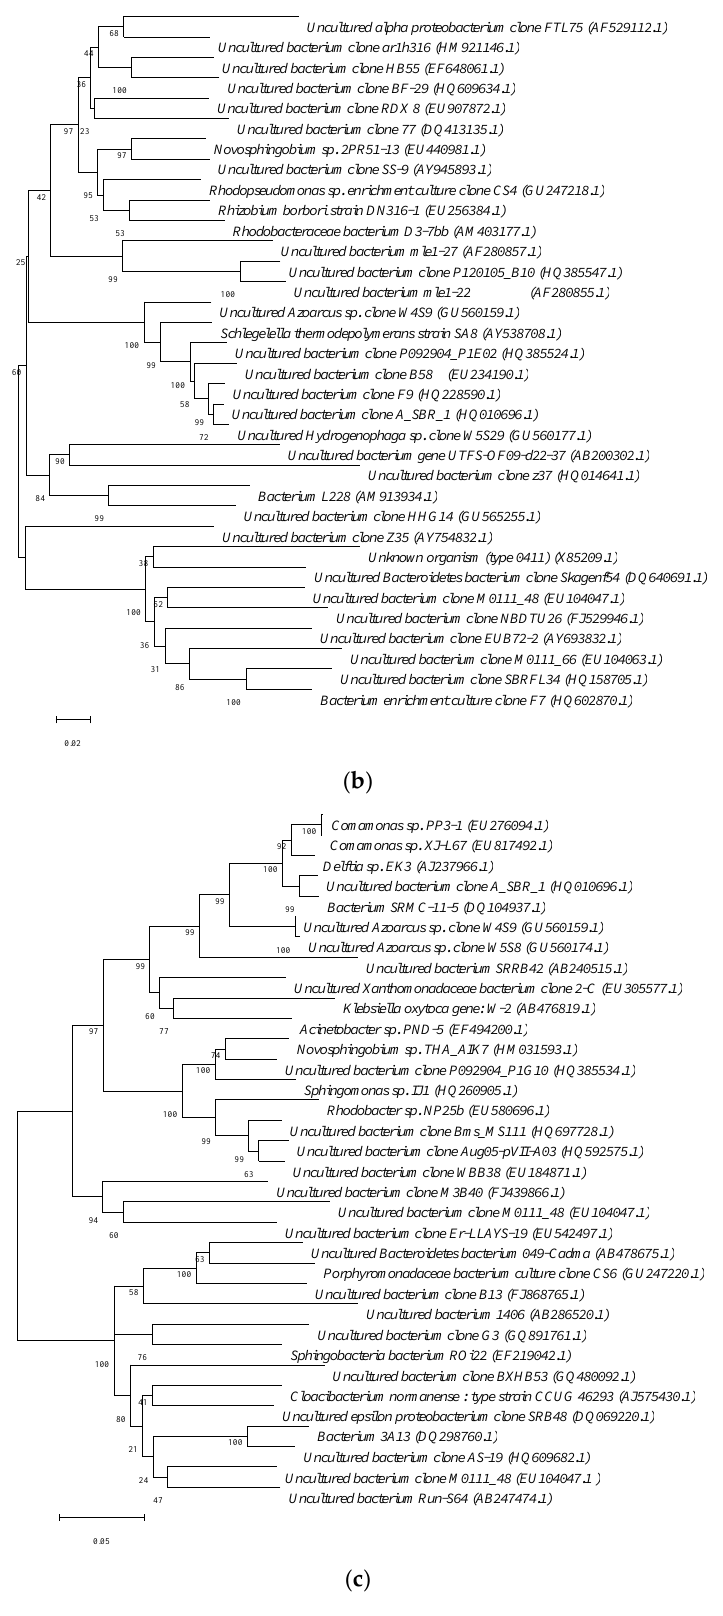
Figure 4. Phylogenetic tree for the total bacterial community in AGS at different stages ( a ) 15 d, ( b ) 40 d, and ( c ) 80